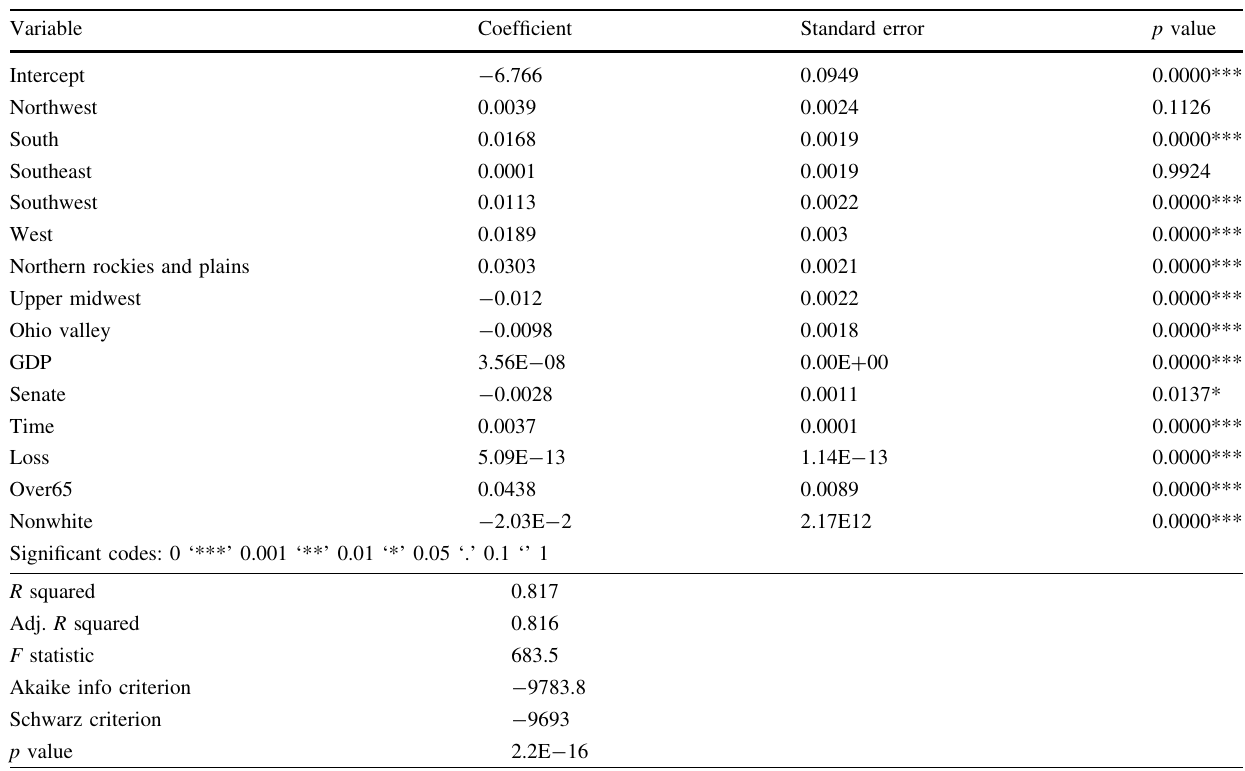
Table 3 Region-specific fixed effects model results for the United States for the period 1970–2013